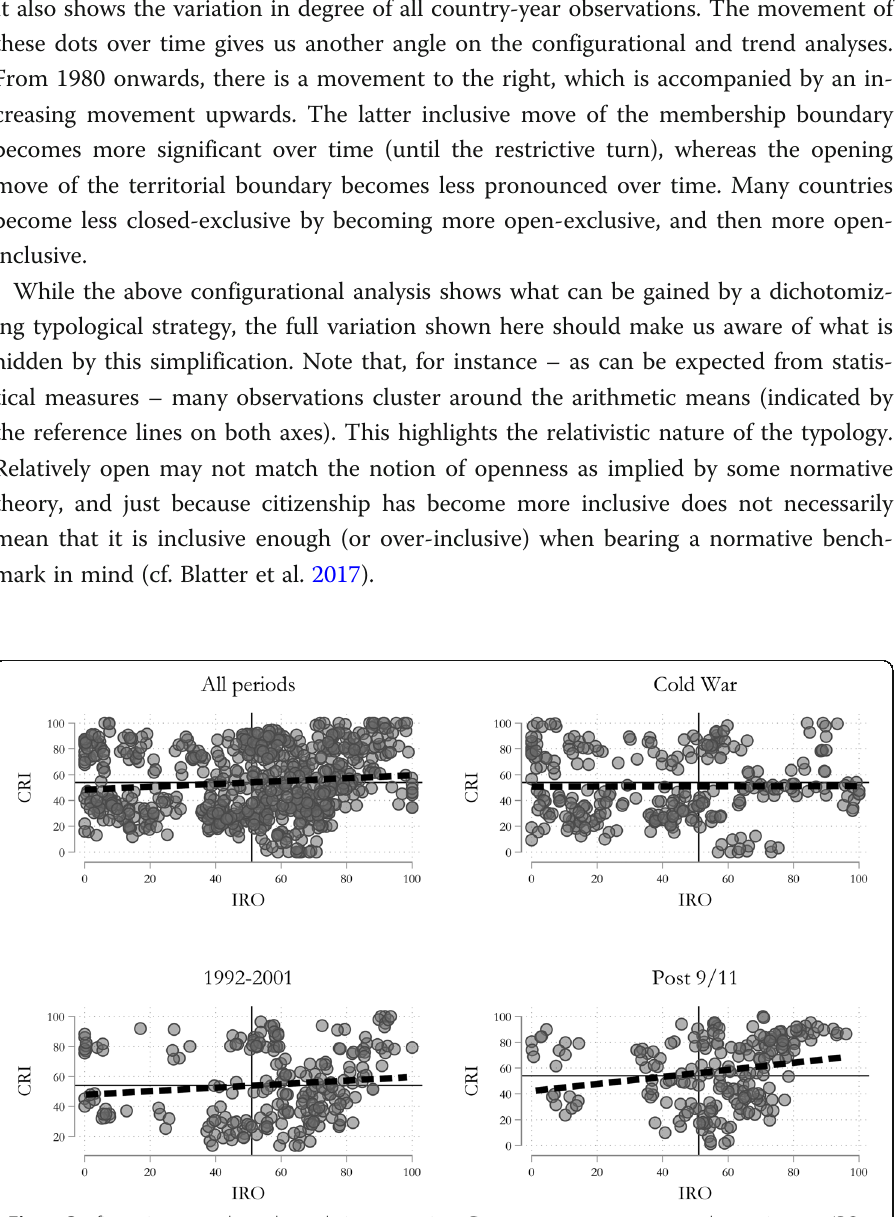
Fig. 4 Configurations, trends, and correlations over time. Dots represent country-year observations on IRO and CRI; reference lines indicate the arithmetic means in IRO and CRI; thick dashed line shows a linear fit to indicate the correlation; IRO is based on selected policy components measuring the openness of immigration regimes according to IMPIC (Helbling et al. 2017). CRI is composed of the policy components of CITRIX (original dataset based on temporal expansion of selected items from MIPEX and based on the data by Stadlmair (2017) and Fitzgerald et al. (2014) and DEMIG and GLOBALCIT) measuring the inclusiveness of citizenship